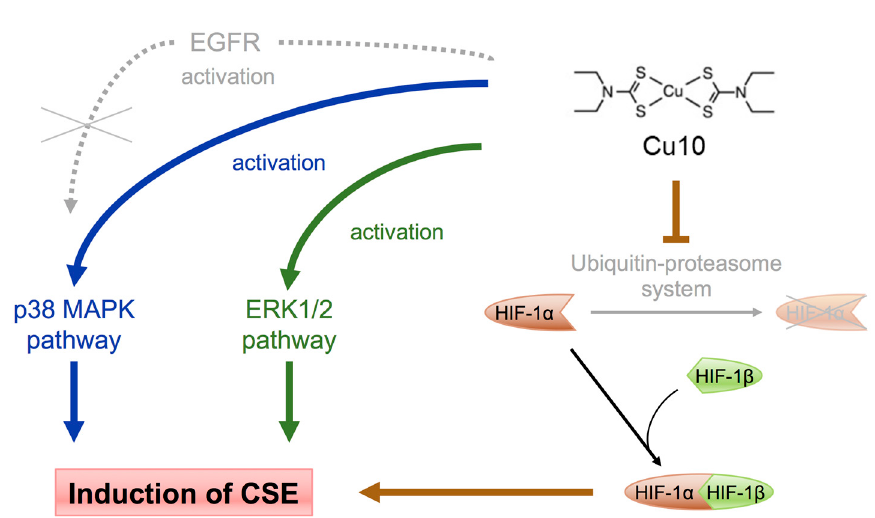
Figure 6. Intracellular signal pathways that mediate the transcriptional induction of CSE by Cu10 in vascular endothelial cells. Involvement of activation of the MAPK (ERK1 / 2 and p38 MAPK) and HIF-1 α / HIF-1 β pathways by Cu10 was shown in the present study, although the mechanisms underlying the activation remain to be